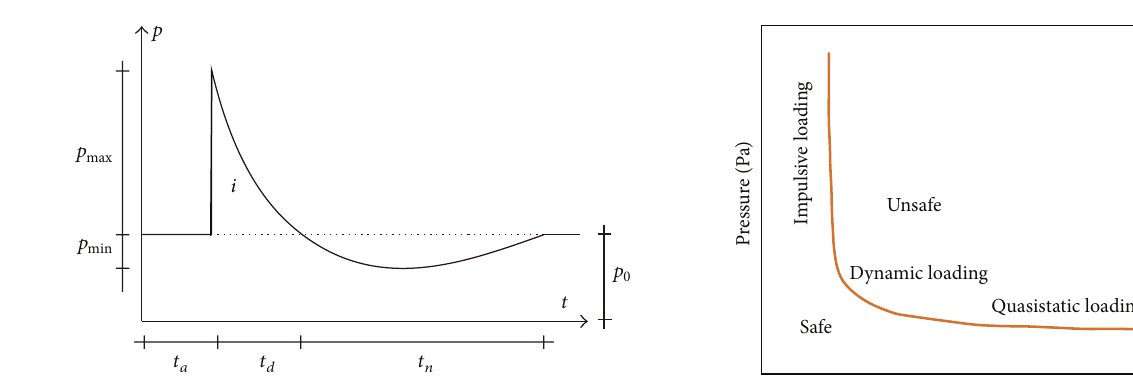
representation using finite elements. Elements are charac- terised by three main